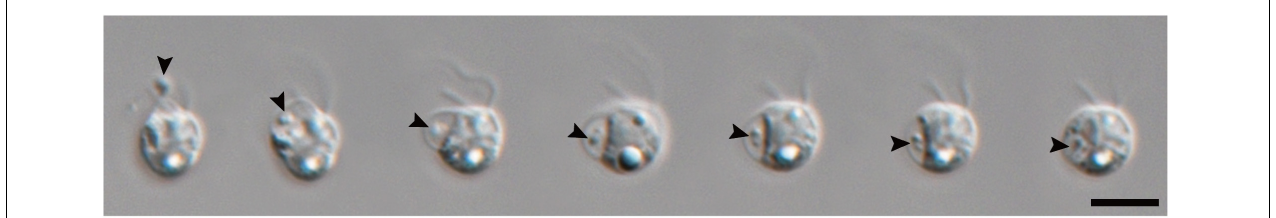
FIGURE 7 | Serially captured LM images of four feeding phases of S. rotundata . Arrowheads indicate bacteria. Scale bar = 5 µ m.